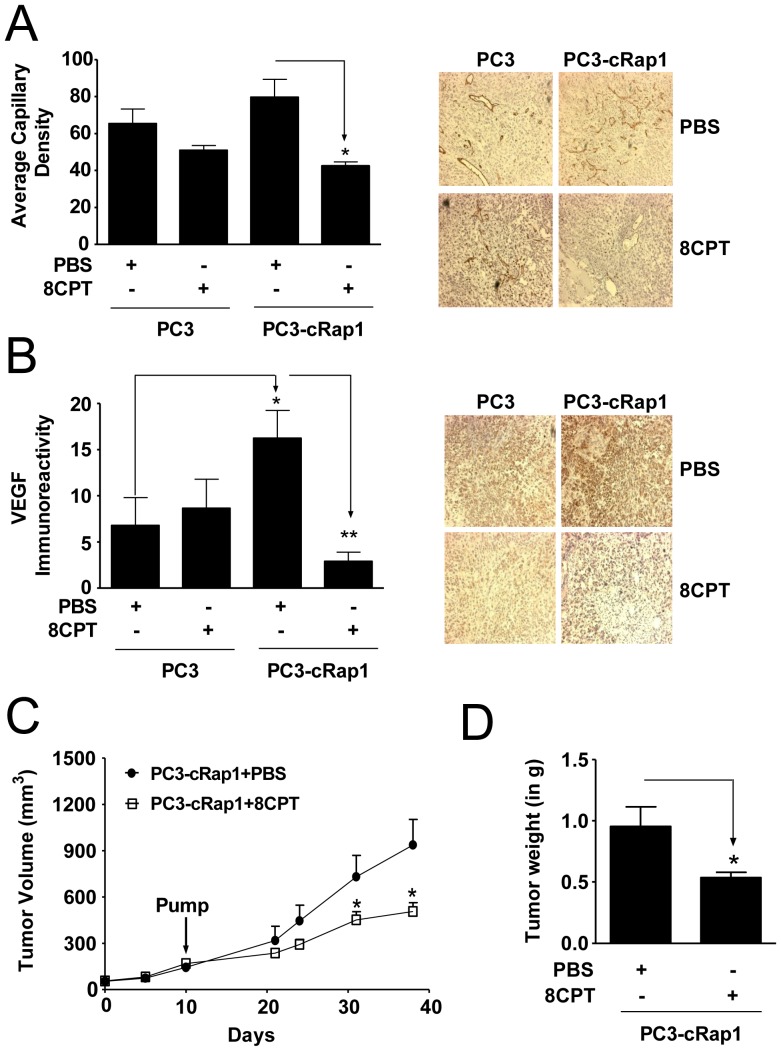
Effect of 8CPT treatment on angiogenesis and tumor growth in PC3 and PC3-cRap1 xenografts.(A and B) CD31 and VEGF immunoreactivity in PC3 and PC3-cRap1 tumors. Immunostaining was measured as described in Methods. Right Panels: Representative photomicrographs. Left Panels: Quantification of immunohistochemical staining of tumor slices; *p<0.05; n = 7; a.u. = arbitrary units. (C) Tumor volume (expressed in mm3) of human PC3-cRap1 xenografts. PC3-cRap1 cells were injected as xenografts at Day 0 and allowed to grow for 10 days before a osmotic minipump containing the treatments was implanted for constant infusion (Day 10, pump). Tumors treated as indicated were measured as described in Methods; *p<0.05; n = 8 for each group. (D) Tumor weight of human PC3-cRap1 xenografts. Tumors from panel C were weighed at the end of the experiment (Day 38) and expressed in grams; *p<0.05; (n = 8).